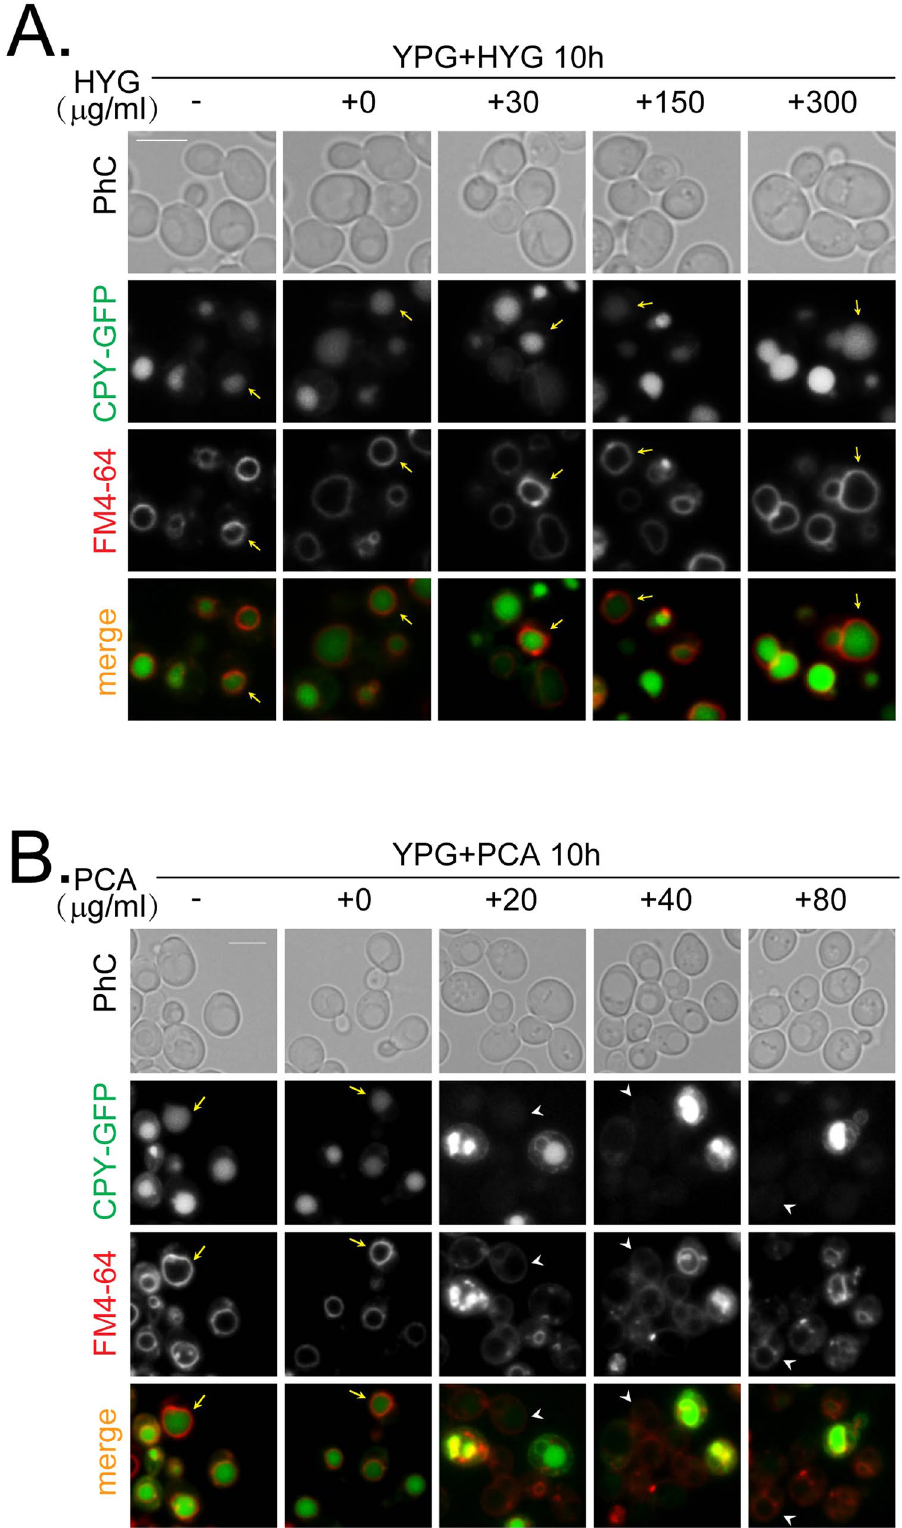
Figure 6. Treatment with PCA disrupts the trafficking of CPY differently than hygromycin B. ( A ) Wild-type cells tagged with CPY-GFP were grown in YPG at an initial OD 600 = 0.1 with different concentrations of HYG in YPD for 10 h. FM4-64 was added in the last hour to stain the vacuoles. ( B ) Cells were grown and treated as in panel A, except that PCA was used at the indicated concentrations. The bar represents 5 μ m. Arrows indicate internalized CPY in the vacuoles. Arrowheads indicate disrupted CPY internalization. Results shown in this figure represent two independent